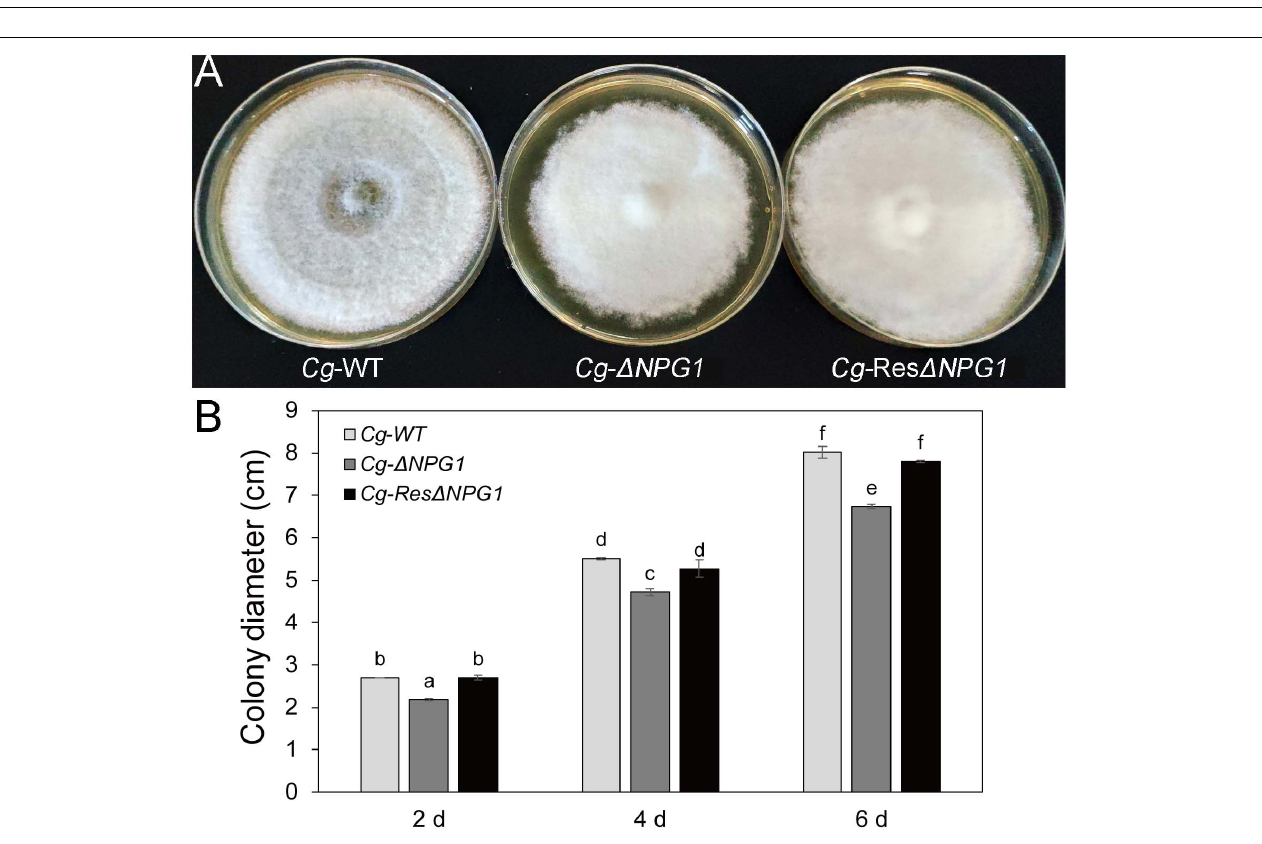
Frontiers in Microbiology |